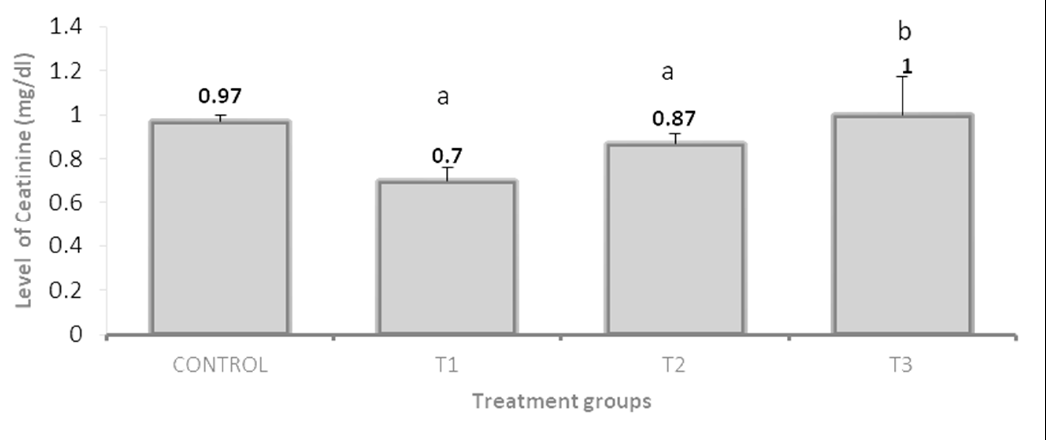
Figure 7. Effect of pomegranate peel and garlic powder separately or in combination on the level of serum creatinine of female rabbits. Values are presented as means ± SE (n = 5 litters). T1; pomegranate peel 3%, T2; garlic 3%, and T3; pomegranate peel 1.5% + garlic 1.5%. a Significant difference as compared to control, b Significant differences as compared to T1 ( p < 0.05).